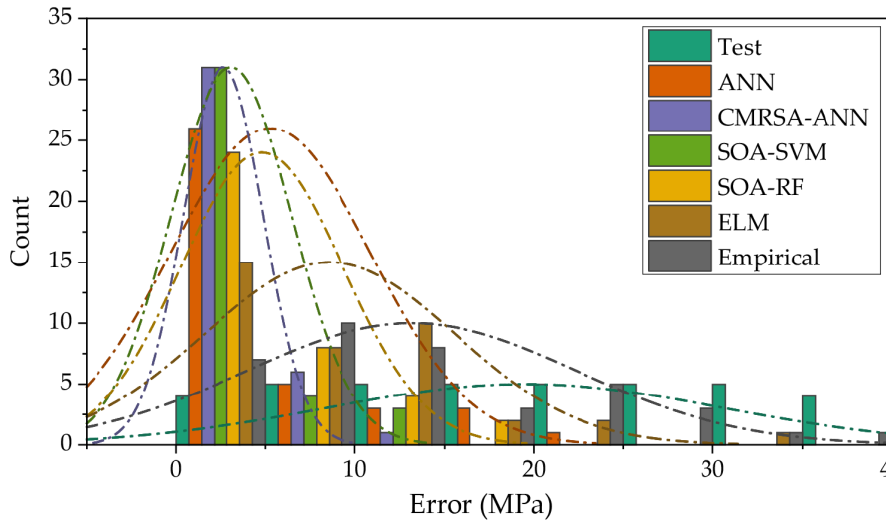
Figure 9. Error distribution of each prediction model in the testing phase.